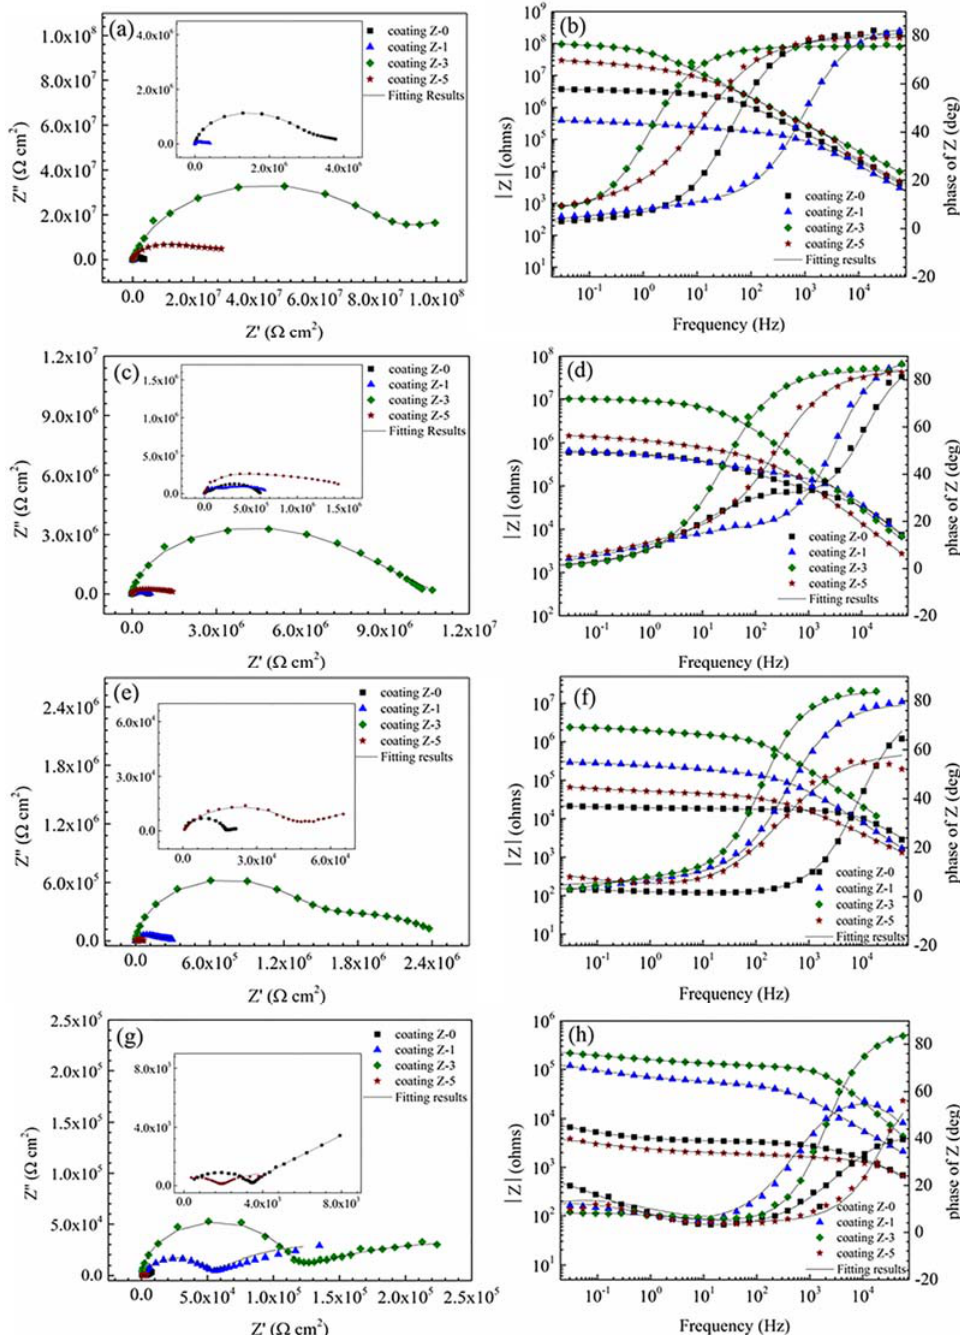
Figure 8. Typical Nyquist and Bode plots for nano-ZrO 2 -modified coatings after different acid immersion times at 60 °C: 30 min ( a , b ), 24 h ( c , d ), 120 h ( e , f ), and 192 h ( g , h ).